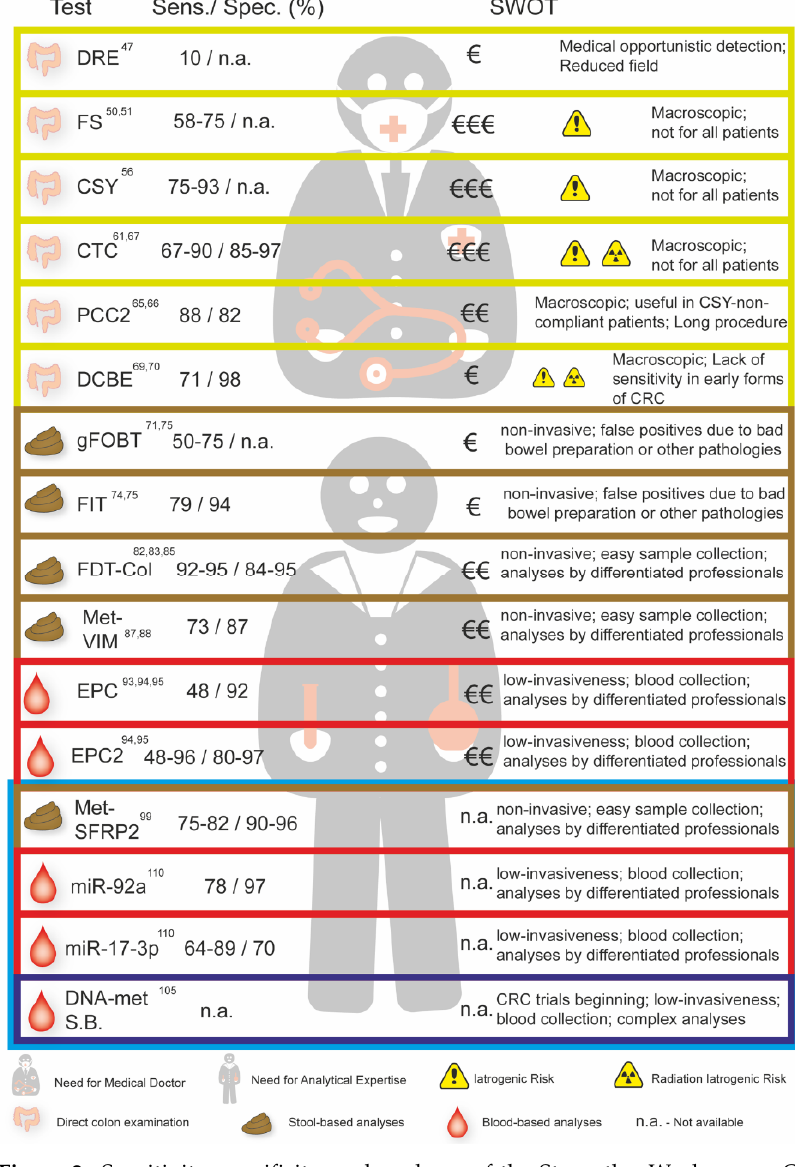
Figure 2. Sensitivity, specificity, and analyses of the Strengths, Weaknesses, Opportunities, and Threats (SWOT) of the different CRC screening tests currently available and in clinical trials (blue box). SWOT analyses including the costs, strengths, and weaknesses of each screening test are summarized. DRE—Digital Rectal Examination; FS—Flexible Sigmoidoscopy; CSY—Colonoscopy;